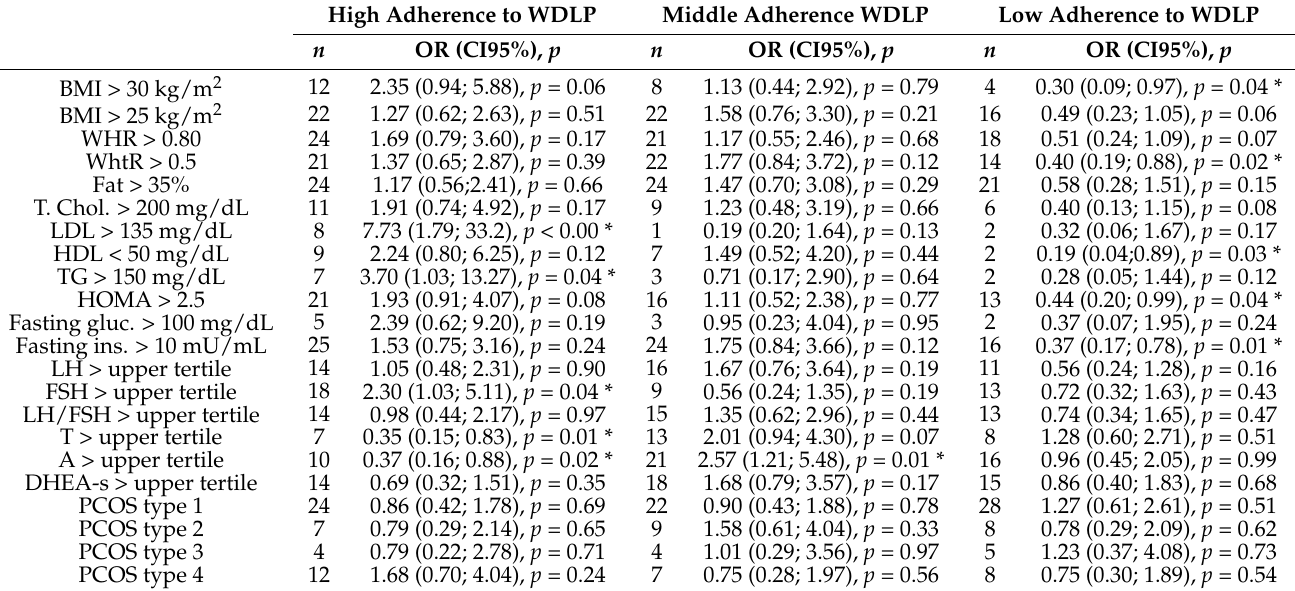
Table 2. The adherence to the western dietary-lifestyle pattern (DLP) and its relation with different metabolic and endocrine